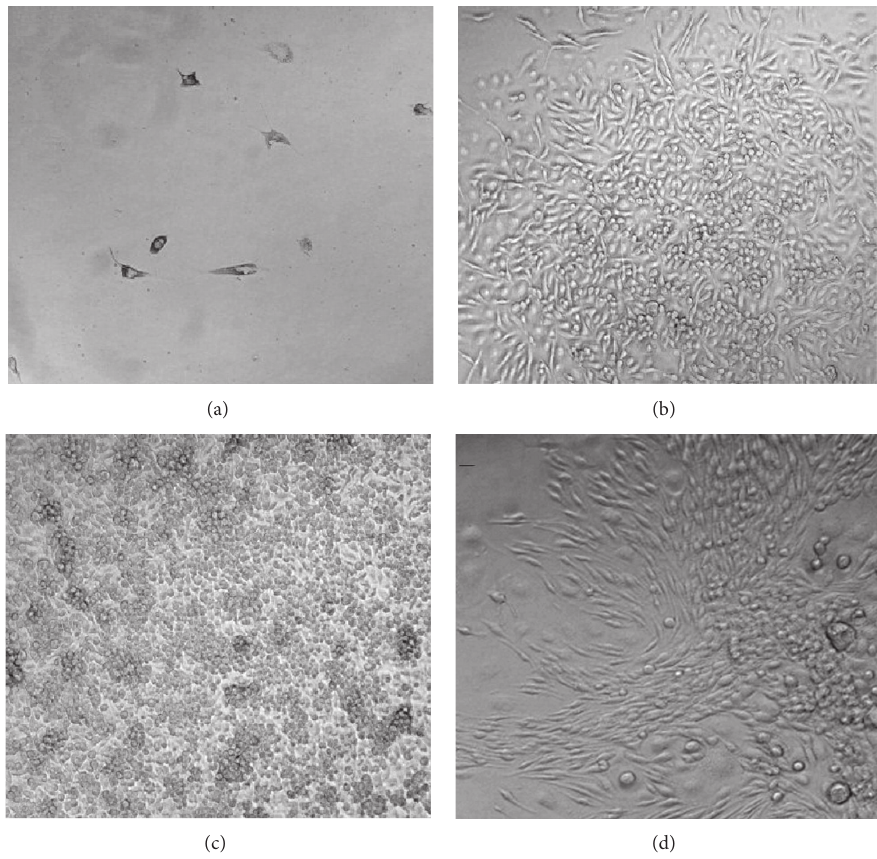
Figure 2: Morphology and proliferation of the cultured microglial cells in different percentages of the L929 conditioned supernatant. (a) Mixed retinal culture grown in 0% L929 supernatant yielded few cells. (b) 10% and (c) 20% of L929 conditioned supernatant produced the highest yield. (d) 30% L929 conditioned supernatant produced less yield compared to 20%. Microglial cells were observed using a phase- contrast Olympus microscope and Prog Res C14 imaging software. Magnification × 20. Data are representative of 3 experimental